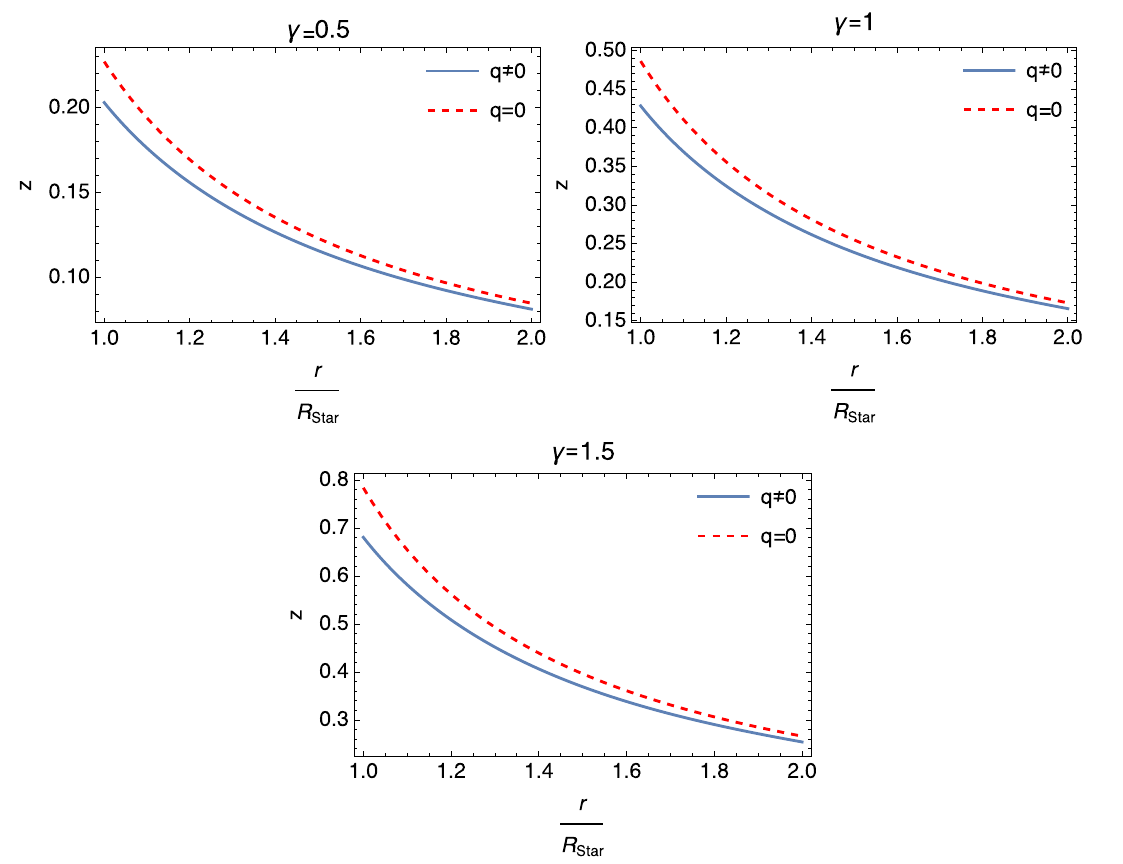
Fig. 17 The graphs show the variation in the redshift z versus r for the compact object VelaX-1. The plots are generated for static charged R Star ( q (cid:8)= 0 ) and static uncharged ( q = 0 ) cases. Variation for each case are shown on the same graph for different values of deformation parameter